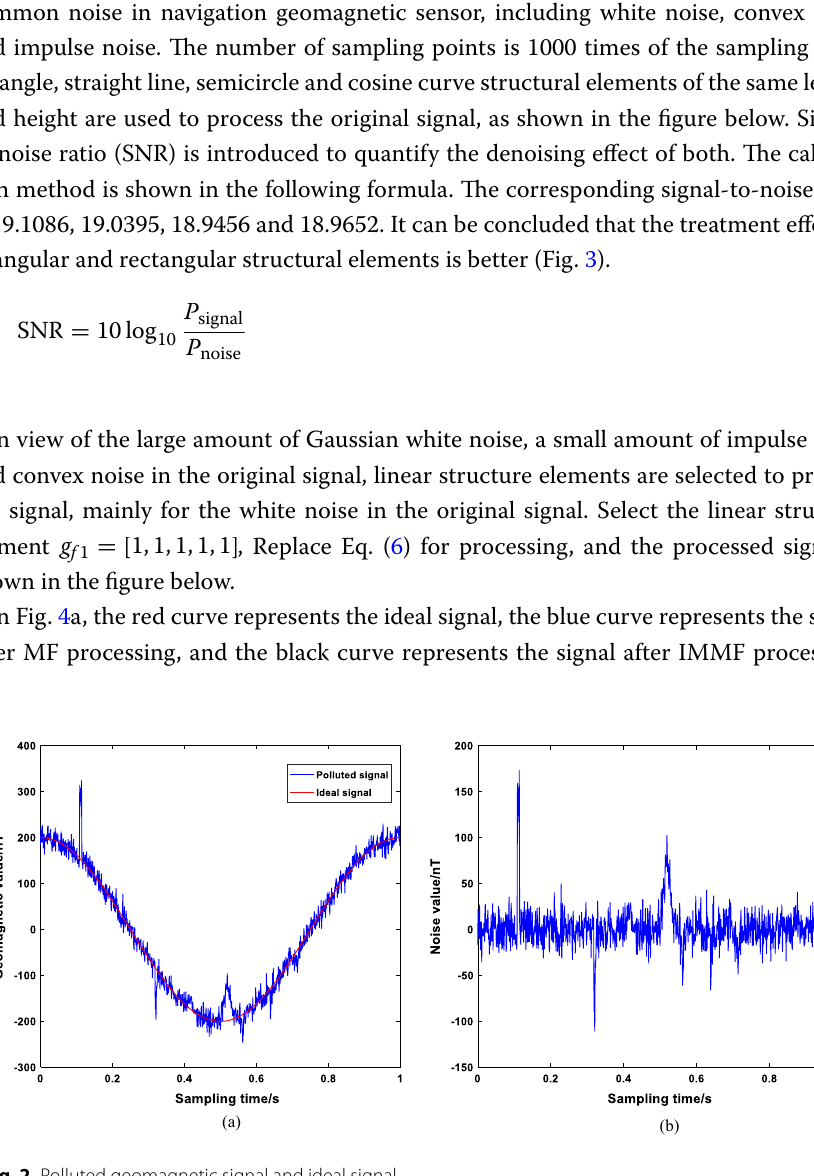
Fig. 2 Polluted geomagnetic signal and ideal